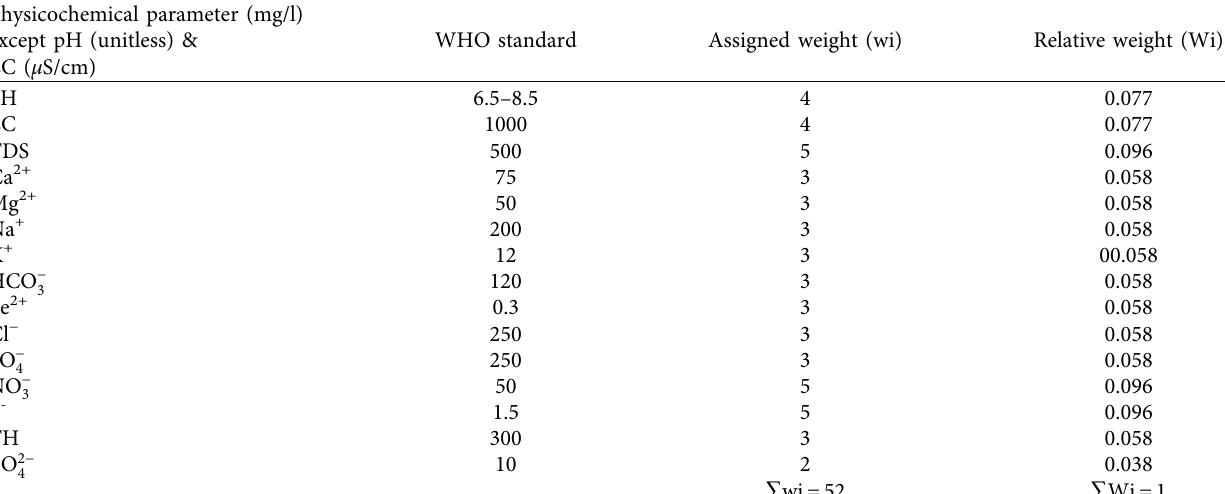
Table 5: World health organization (WHO) standards, weight (wi), and relative weight (Wi) for each parameter of the groundwater samples in the